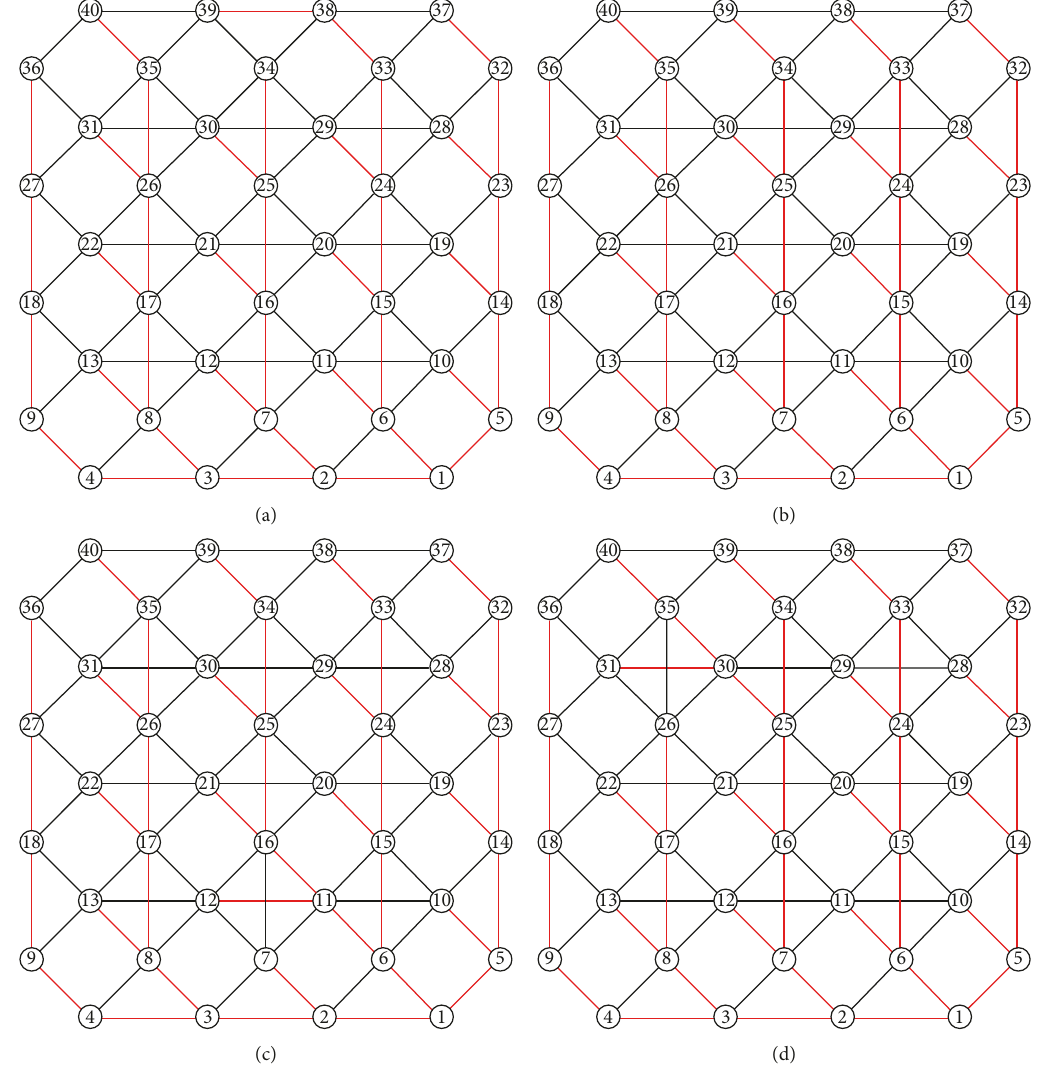
Figure 10: Shortest paths of the line